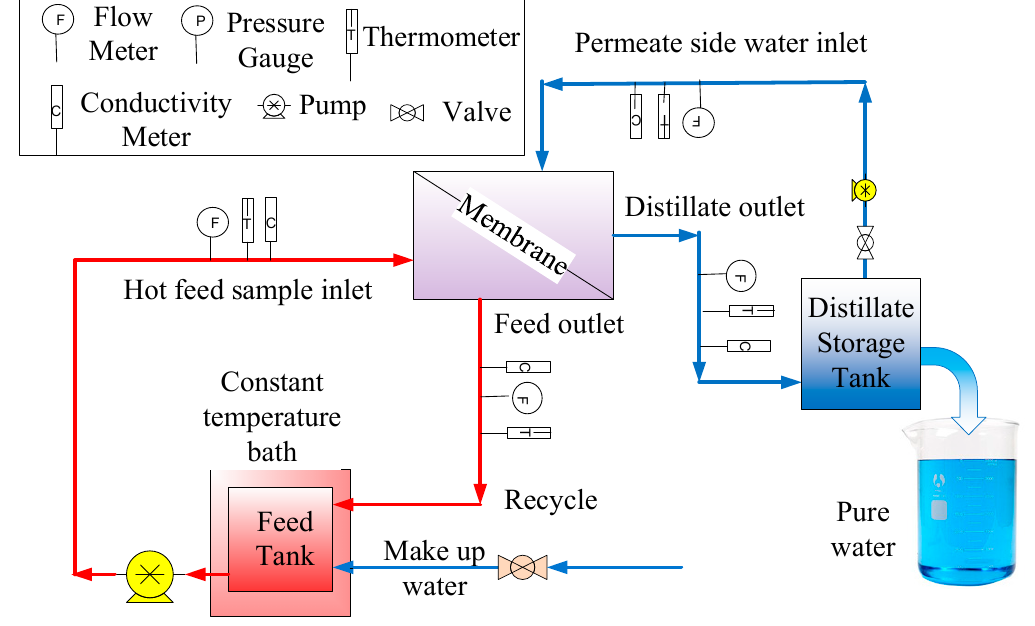
Figure 1. Schematic diagram of the experimental set up for direct contact membrane distillation (DCMD) application.